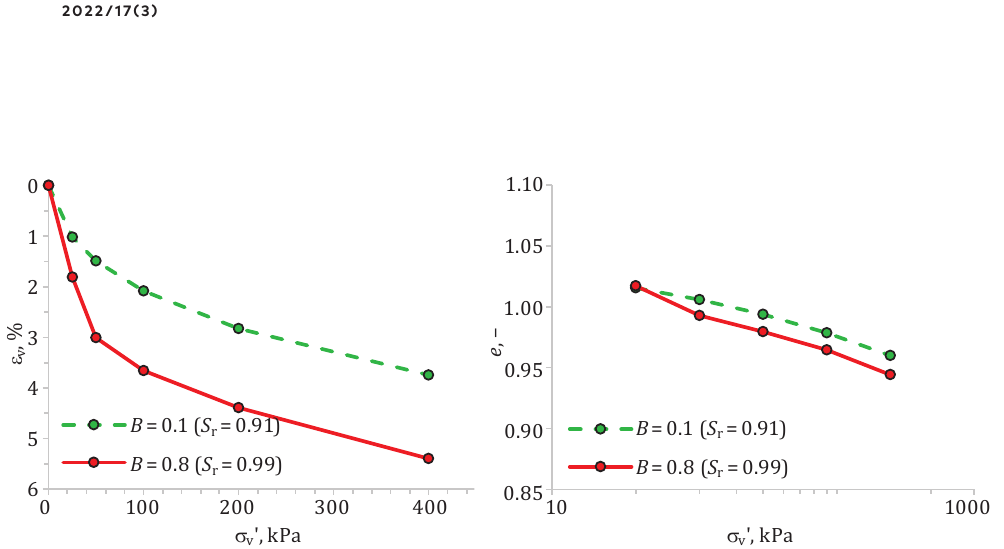
Figure 4. Vertical compression ε v , % versus pressure σ v ’, and void ratio e versus log pressure σ v ’ plots of saturated and non-saturated fly ash sample